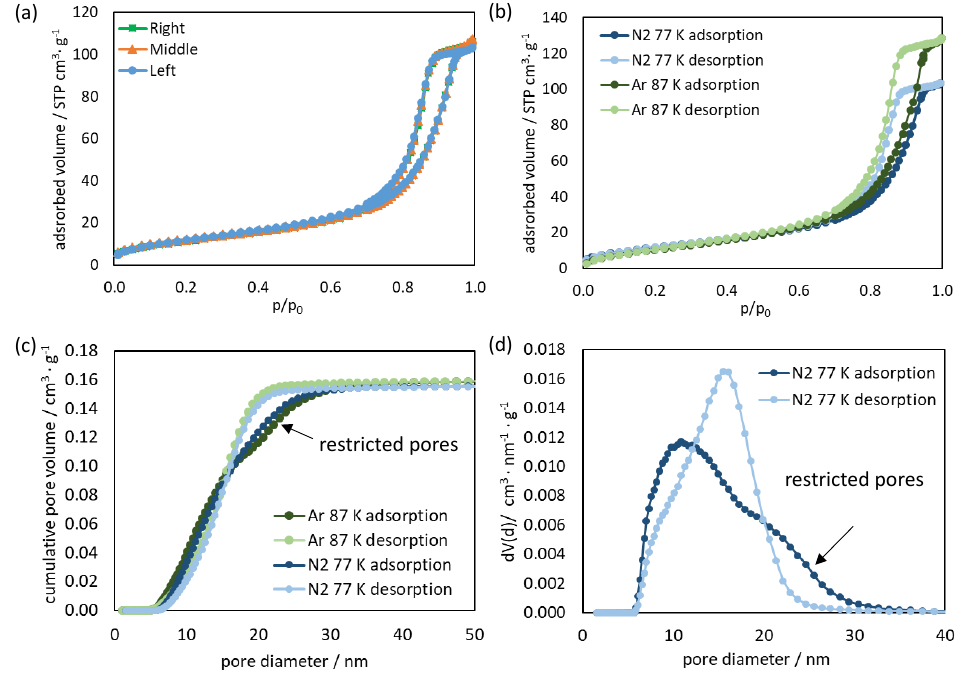
Figure 4. Textural characterization of thin-layer packing. ( a ) N 2 77 K adsorption isotherms of the three subsamples (left, middle and right part), ( b ) N 2 77 K and Ar 87 K adsorption isotherms of the left sample, ( c ) cumulative pore volume determined from the Ar 87 K and N 2 77 K adsorption branches using a dedicated NLDFT metastable adsorption branch kernel (assuming N2 and Ar adsorption, respectively in cylindrical silica pores) in comparison with the cumulative pore volume determined from the Ar 87 K and N 2 77 K desorption branches using the corresponding NLDFT equilibrium kernel and ( d ) pore size distribution calculated from the N 2 77 K adsorption branch using a dedicated NLDFT metastable adsorption kernel and from the N 2 desorption branch using a dedicated NLDFT equilibrium kernel.